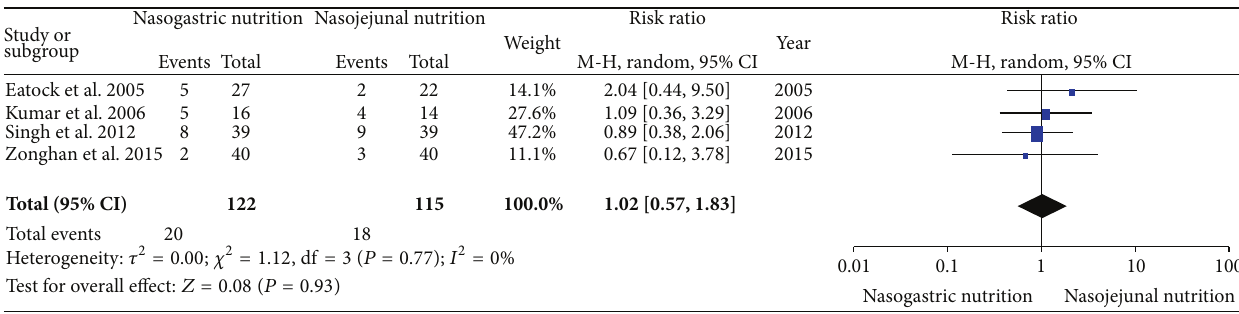
Figure 5: Comparison of the digestive complications between the NG and NJ nutrition